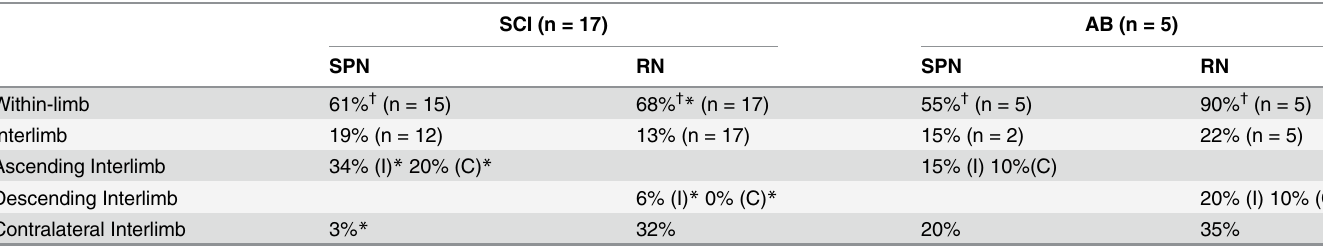
Table 2. Incidence of within-limb and interlimb reflexes.